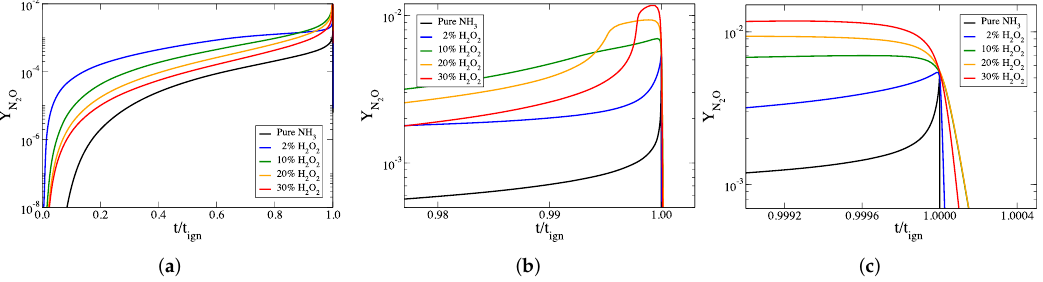
Figure 6. The temporal evolution of the mass fraction of N 2 O against scaled time, for all cases considered: ( a ) the full explosive stage, ( b ) the final part of the explosive stage and ( c ) at ignition.